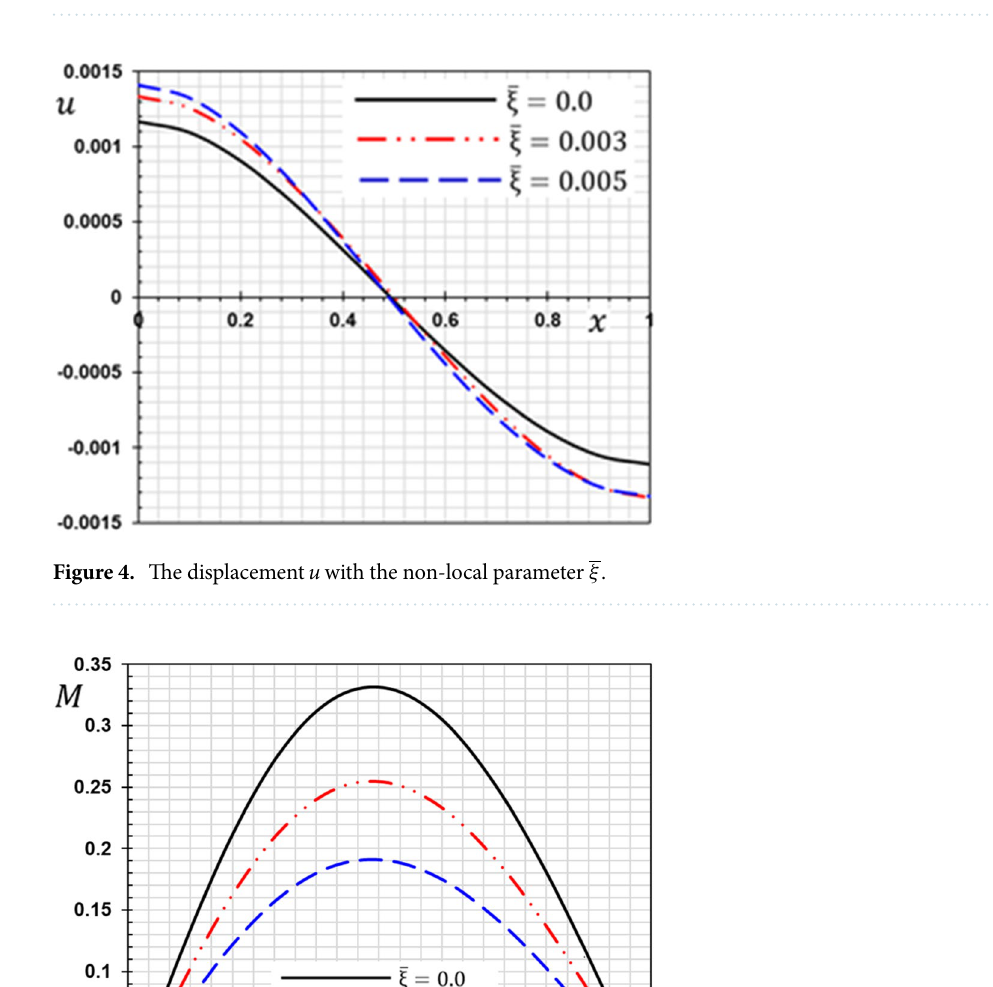
Figure 3. The temperature θ with the non-local parameter ξ .